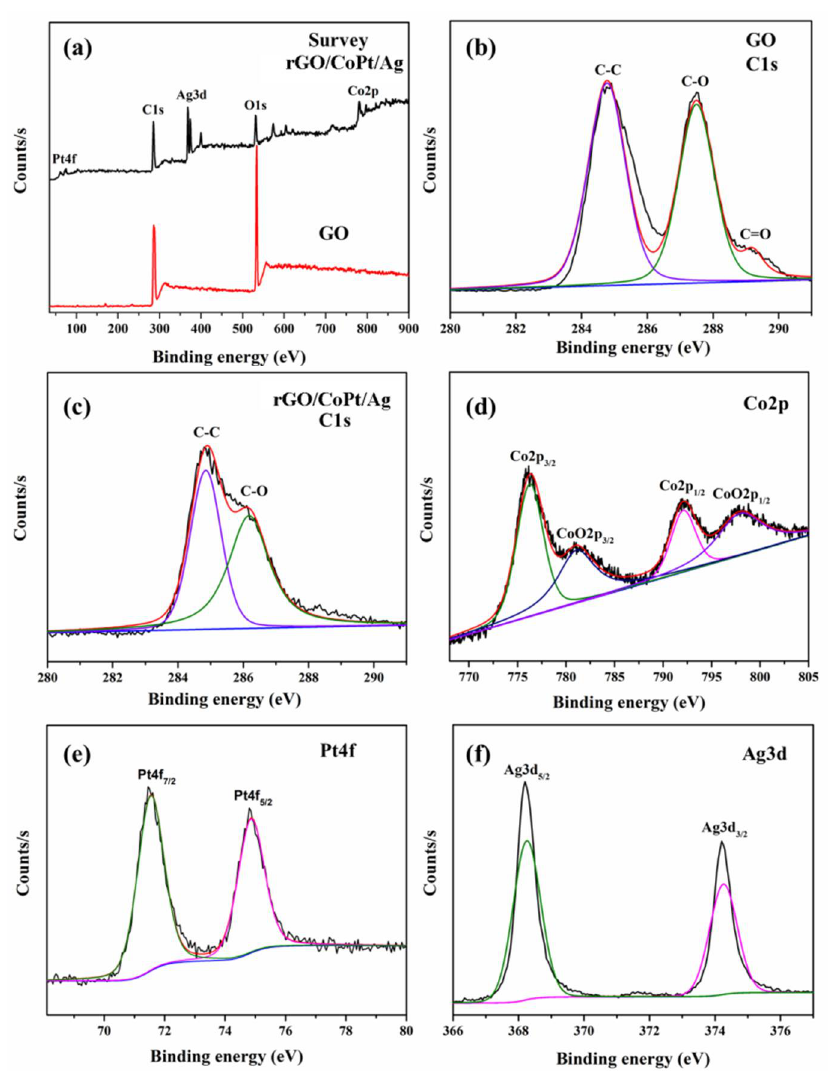
Figure 4. ( a ) Survey XPS spectra of GO and rGO/CoPt/Ag, ( b ) XPS spectra of C1s of GO, ( c ) C1s, ( d ) Co2p, ( e ) Pt4f, and ( f ) Ag3d of rGO/CoPt/Ag. 2.2. Catalytic Applications of CoPt, rGO/CoPt, and rGO/CoPt/Ag